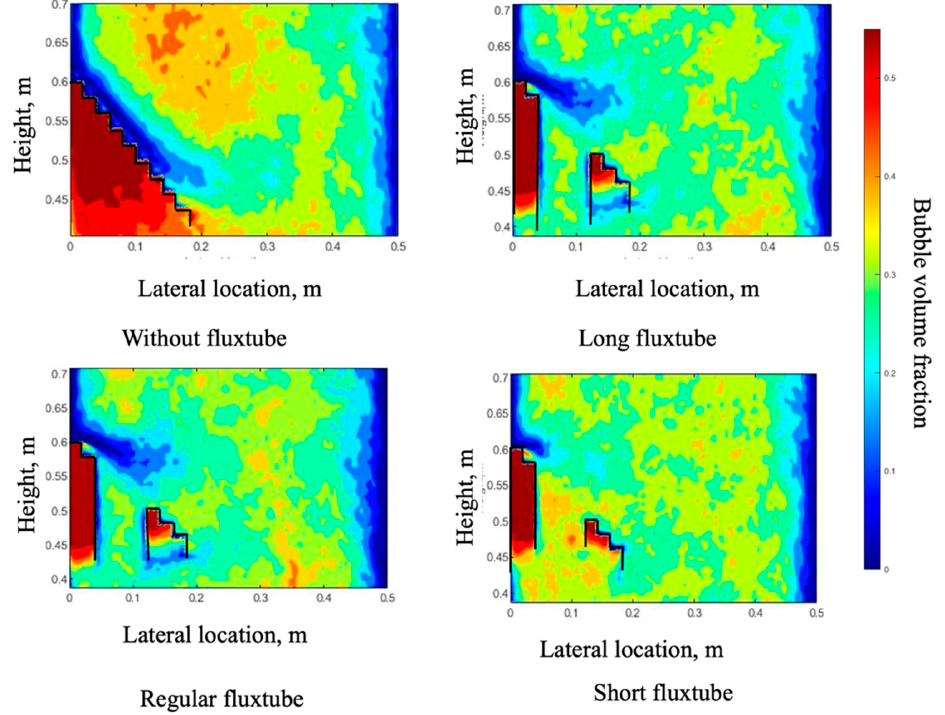
Figure 13. Bubble volume fraction contours at the baffle zone (0.40 m < y < 0.70 m) using the asymmetrical baffle without a fluxtube and with fluxtubes of different lengths under the superficial gas velocity of 0.4 m/s for the even gas inlet configuration.